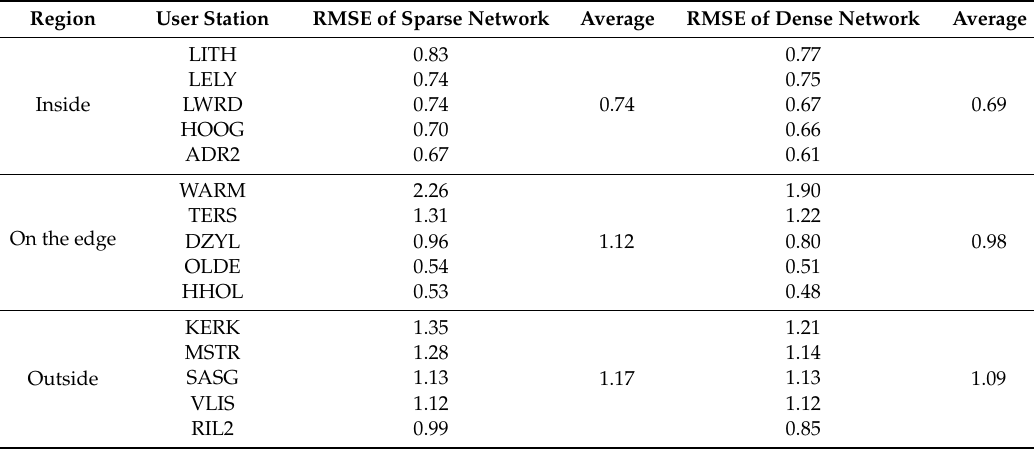
Table 2. Average RMSE of each user station. The unit is cm.